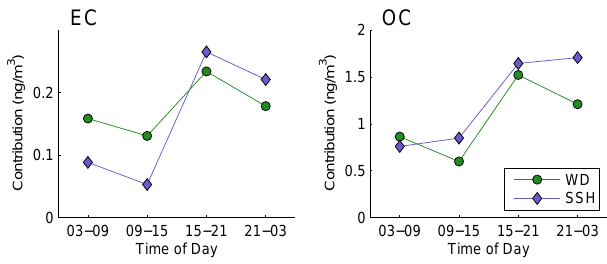
Figure 16. Total contribution to the average concentration of EC and OC in the inverse time series from the residence time analysis grids by time of day for weekdays (WD) and weekends